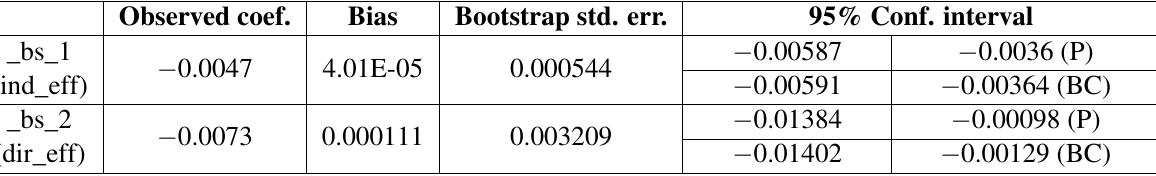
Table 6 Bootstrap method was used to test the mediation effect of product market competitive advantage.